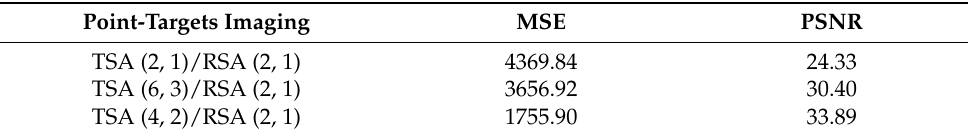
Table 4. Point targets imaging quantitative comparison of SF two − way =